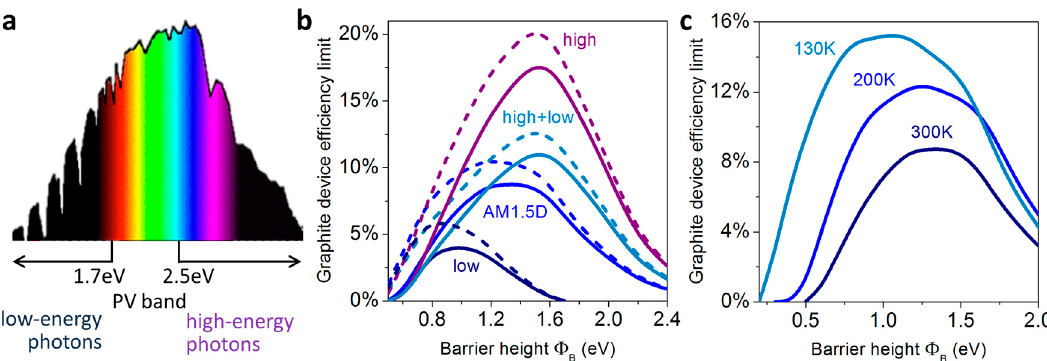
Figure 6. ( a ) The spectral power distribution in the AM1.5D solar spectrum, and one of many possible ways to achieve its spectral splitting into high-energy, low-energy and PV spectral bands; ( b ) Limiting energy conversion efficiencies of the graphite IPE converter as a function of the potential barrier height under partial solar spectrum illumination and varying solar concentration, including: the efficiency of the full solar spectrum conversion (blue) as well as efficiencies of the partial spectrum conversion of high-energy photons ( (cid:125) ω > 2.5 eV, purple lines), low-energy infrared photons ( (cid:125) ω < 1.7 eV, navy lines), and both high- and low-energy parts of the spectrum (light blue lines). Solid curves are for the solar concentration of one sun, dashed lines are for the solar concentration of 100 suns; ( c ) Limiting energy conversion efficiency of the graphite IPE converter for different temperatures of the device (shown as labels) and solar concentration of 100 suns.